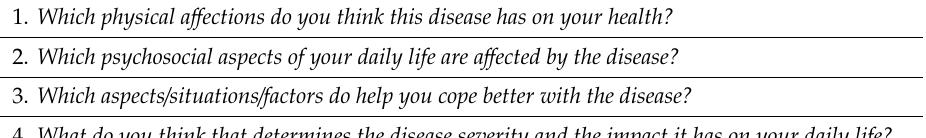
Table 1. Interview